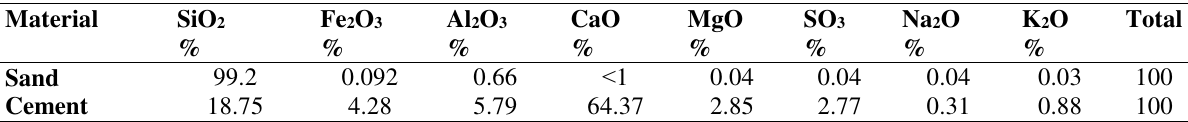
Table 1, Chemical compositions of raw materials